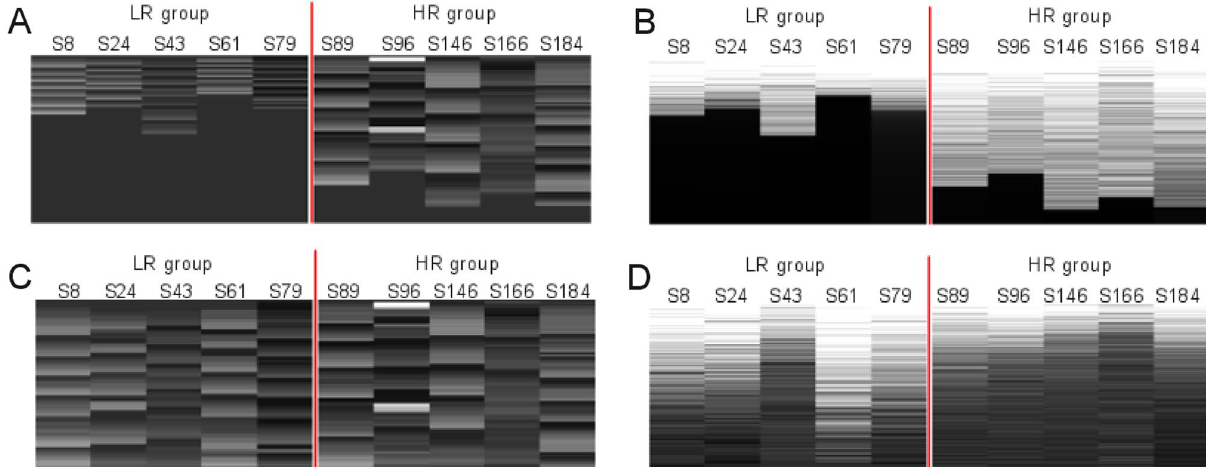
Figure 7. ( A ) Time domain zero padded signals for 5 LR and 5 HR subjects, ( B ) Magnitude spectra of time domain zero padded signals for 5 LR and 5 HR subjects, ( C ) Time domain interpolated and energy normalized signals for 5 LR and 5 HR subjects, ( D ) Magnitude spectra of time domain interpolated and energy normalized signals for 5 LR and 5 HR subjects. Due to the visualization signals/spectra were quantized into the grayscale range < 0–255 > , i.e. 0 is black and 255 is